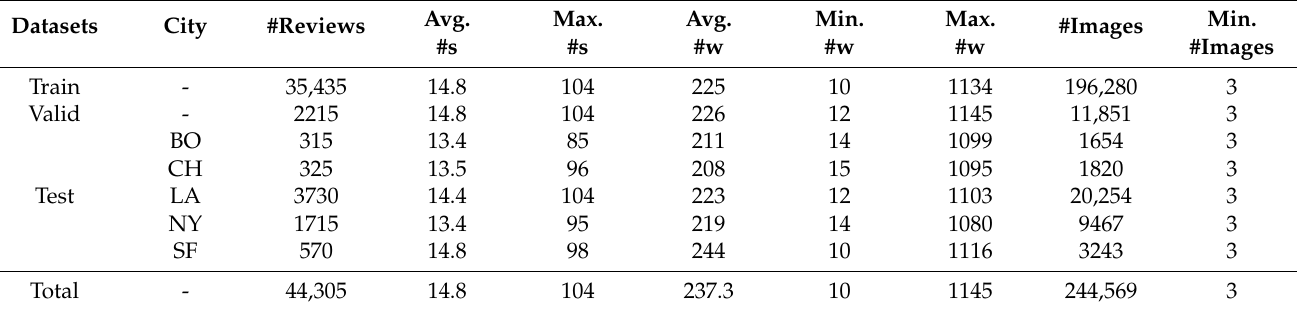
Table 1. Statistics of the Yelp